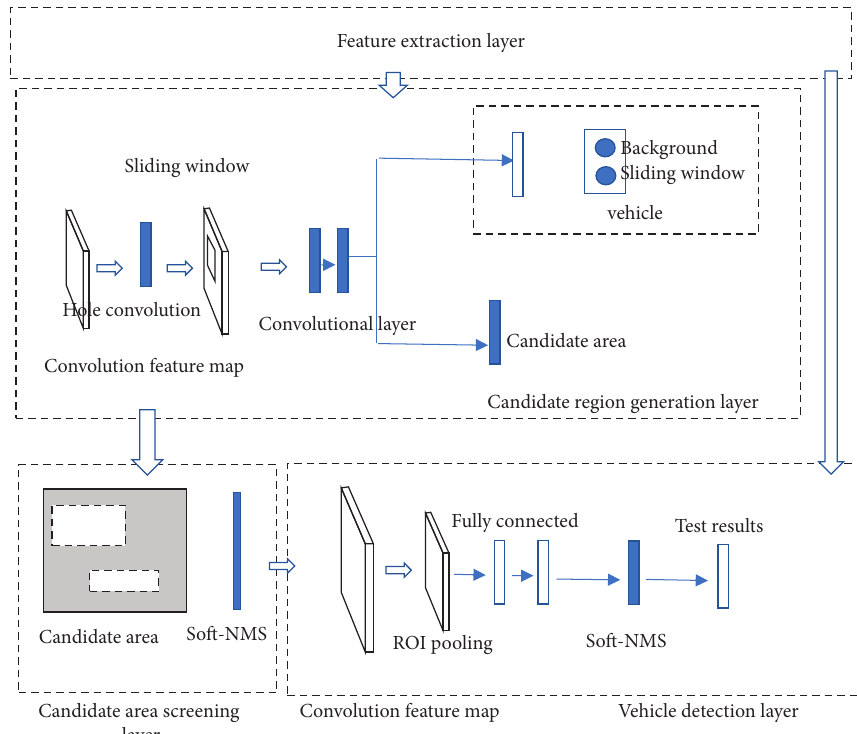
Figure 8: Structure diagram of neural network